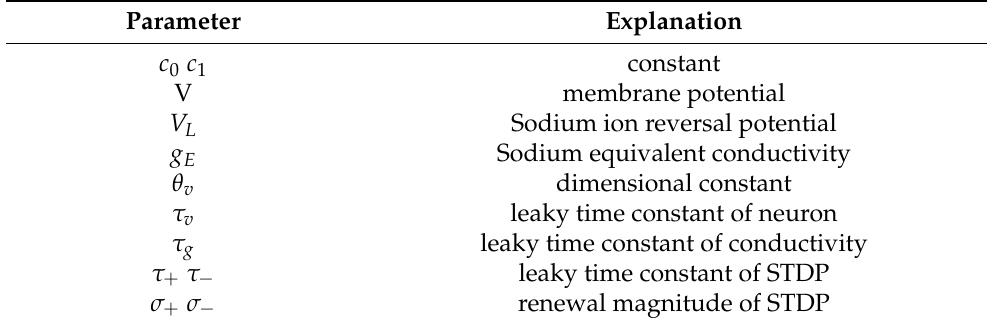
Table 2. Physical significance of parameters.